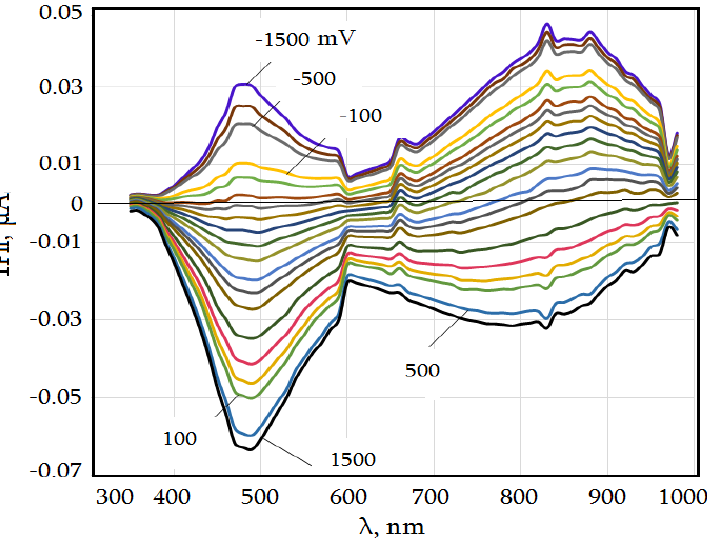
Figure 2. The spectral dependence of the photocurrent of DPB photodetector samples at different bias voltages (in mV).